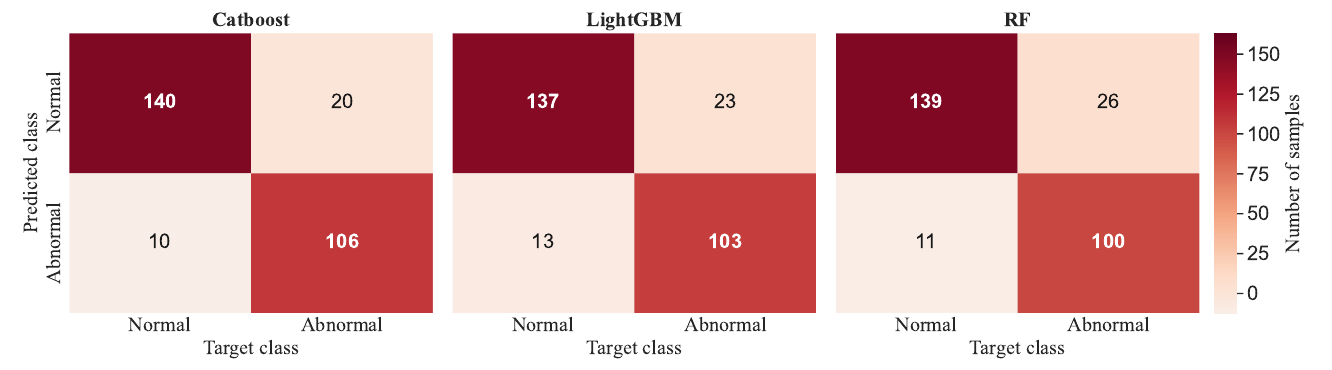
Figure 6. Confusion matrices of different classifiers on the default test set.